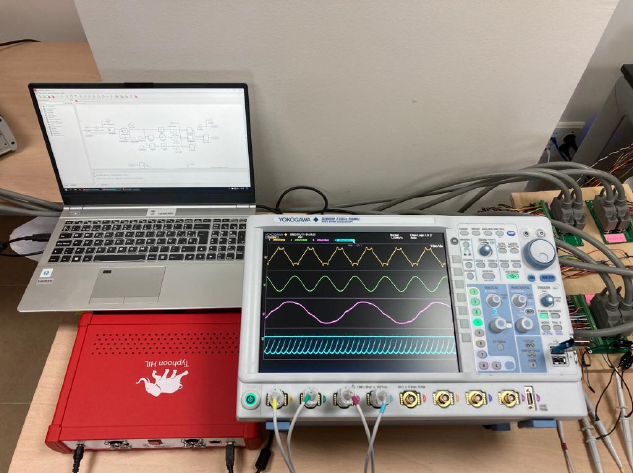
Figure 13. Experimental setup.